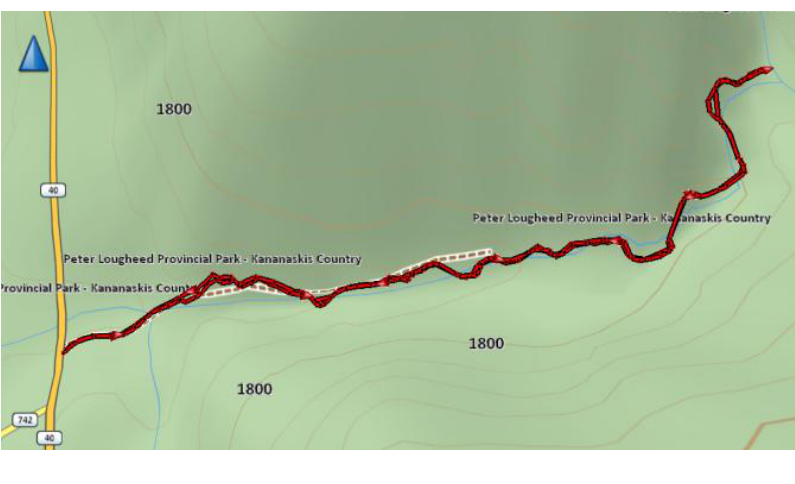
Figure 7. Reference trajectory (natural